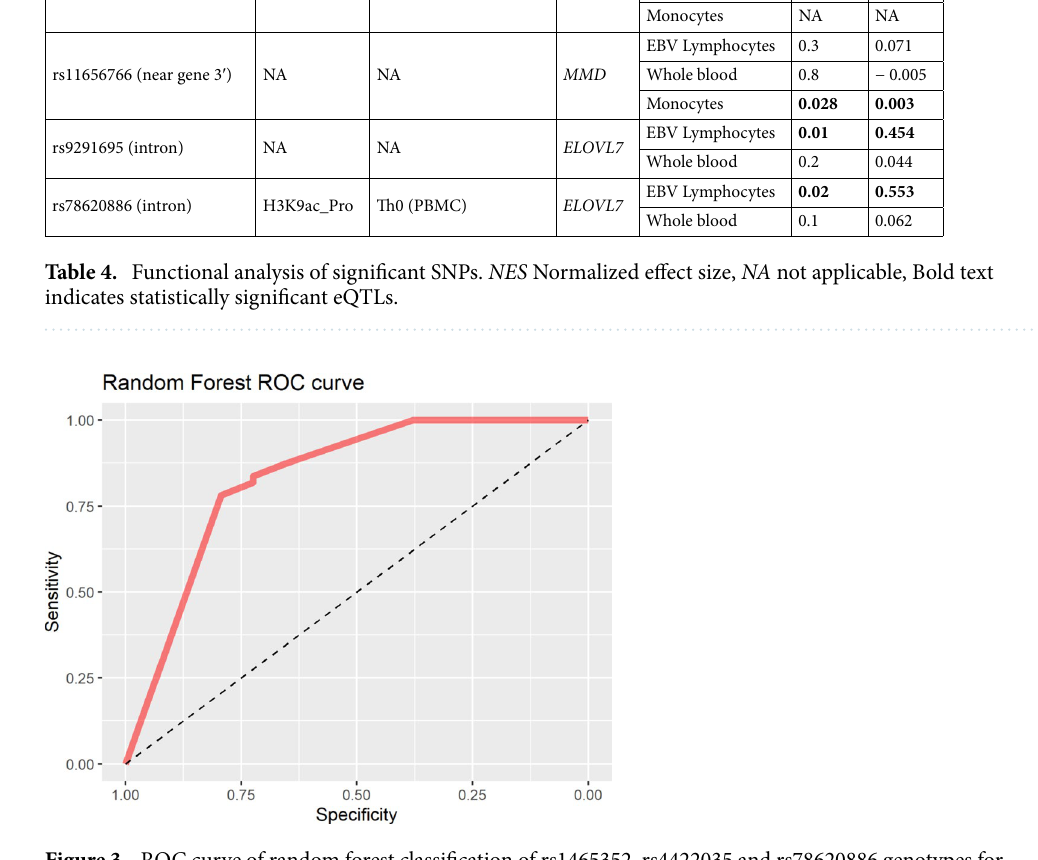
Figure 3. ROC curve of random forest classification of rs1465352, rs4422035 and rs78620886 genotypes for adalimumab response prediction. The ROC curve plot was constructed using ggplot2 R package 23